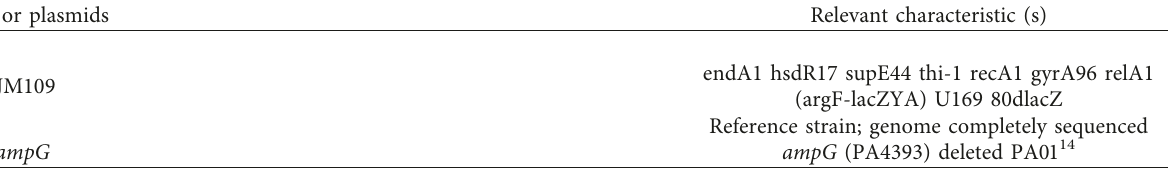
Table 1: Bacterial strains and